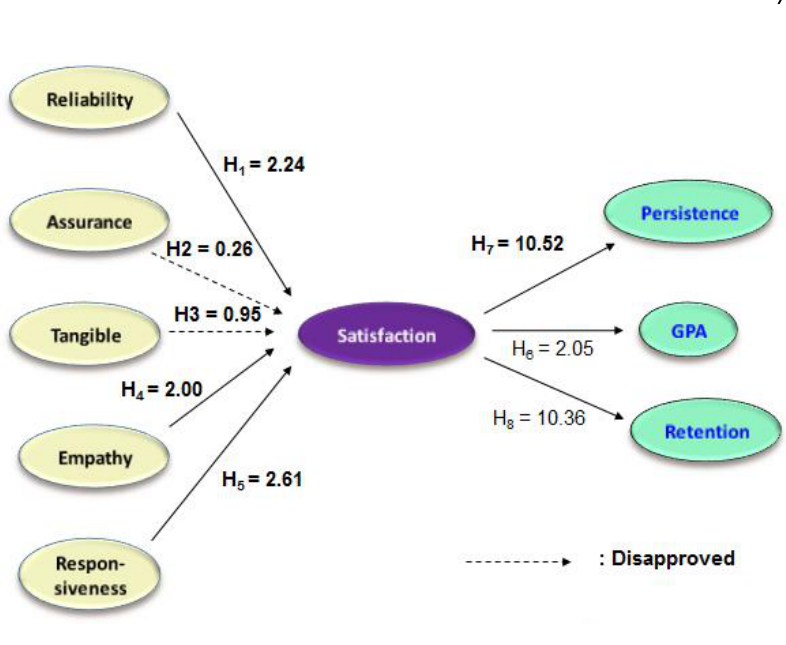
Figure 2 The t -value of the model